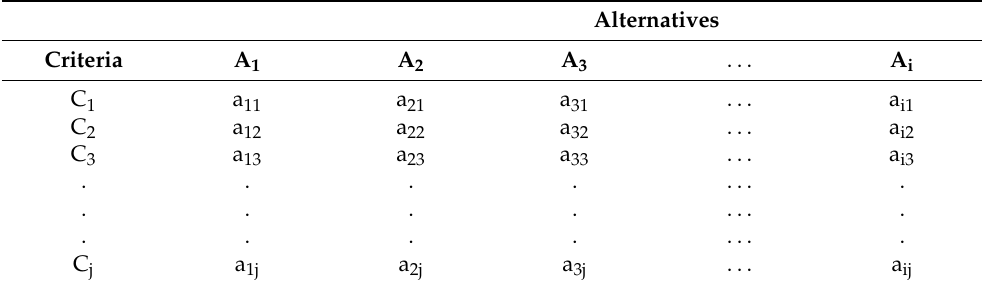
Table 2. Traditional MCDM Matrix with alternative ratings from an individual DM.